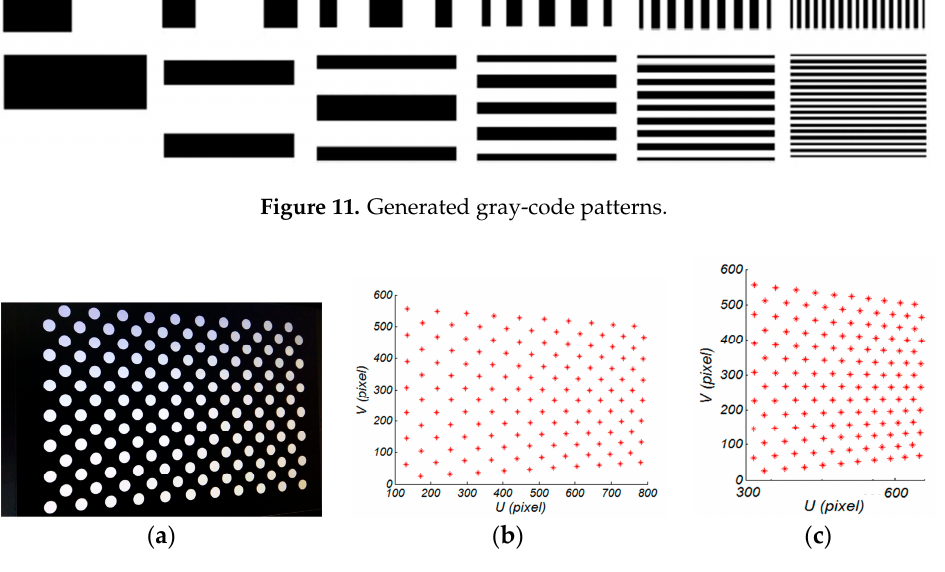
Figure 12. Example of the extracted correspondences circle centers for the camera and projector. ( a ) example of one calibration pose; ( b ) camera; and, ( c ) projector.